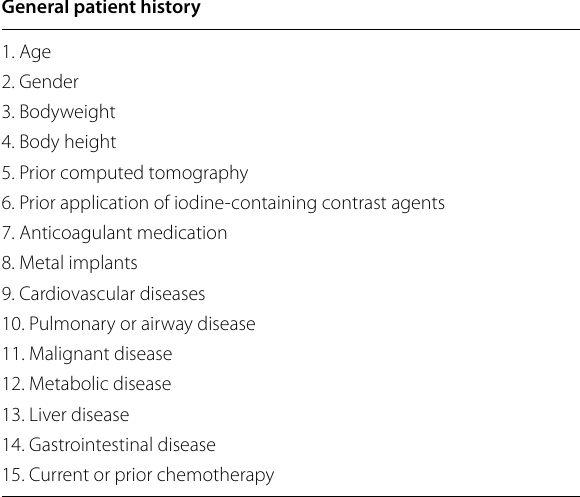
Table 1 General patient history. These items support the evaluation of the justifying CT indication with contrast agent injection, can help adapt the examination protocol and add information to the reporting process